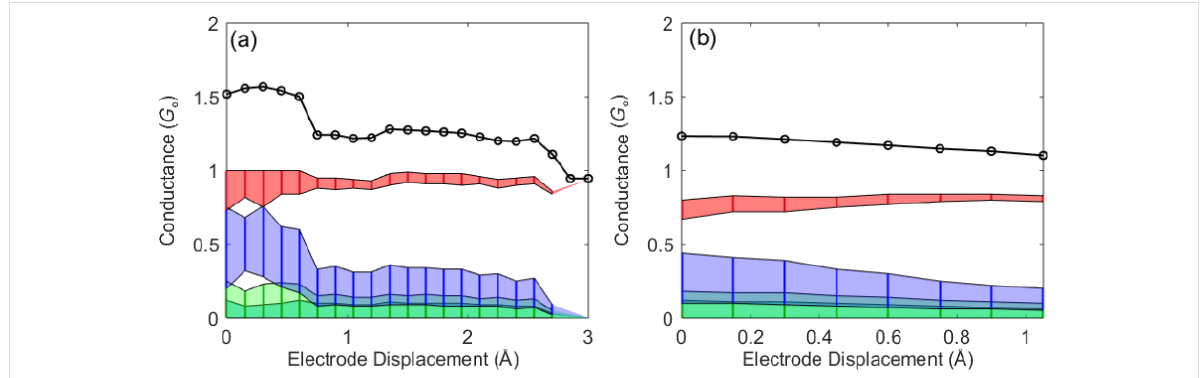
Figure 3: (a,b) Conductance traces measured for the Ag–vanadocene junction (black curve) and the experimentally resolved conductance contribu- tions of the main channels based on conductance and shot noise analysis [20]. For junctions with conductance around 1.3 G 0 only two main chan- nels are always open. In this analysis we assume four spin-degenerate channels. However, repeating the analysis under the assumption of three and two channels gave similar results, indicating that the total conductance is probably dominated by only two channels. Note that spin-resolved channel analysis does not change the overall outcome of a major spin-degenerate contribution of 0.75–1 G 0 and the rest is dominated by a secondary channel. The limited accuracy of the channel analysis stems from avoiding the a priori assumption of only two conduction